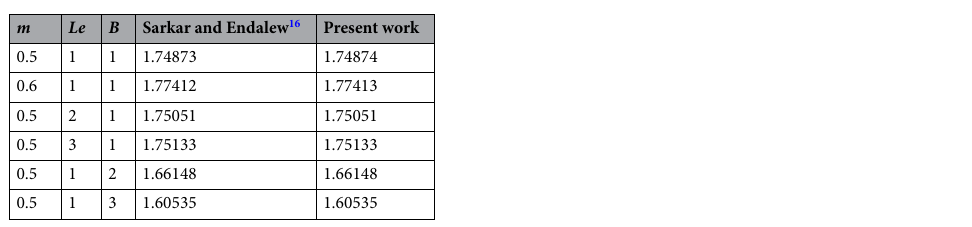
Table 1. Comparison of shearing stress ( f ′′ ( 0 ) ) with existing